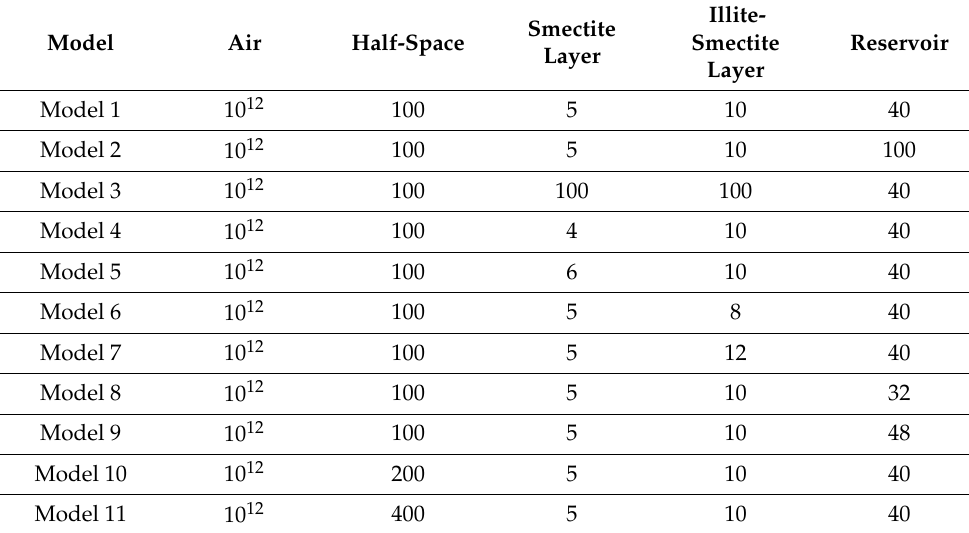
Table 3. The assigned resistivity values for the hydrothermal system, as shown in Figure 5. The resistivity unit is Ω